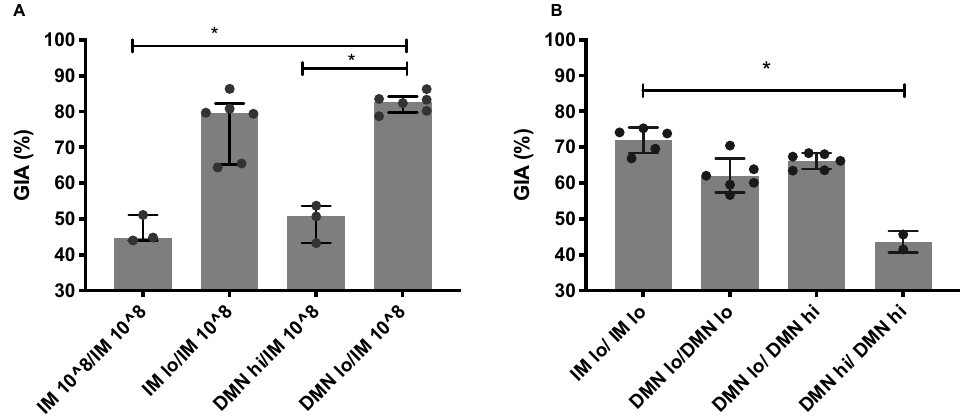
Figure 4. The dose and route of immunization impacts on functional antibody activity against malaria parasites. Female Balb/c mice ( n = 10 per group) were immunized on day 0 with AdHu5–PfRH5 by the IM route or using DMN patches. The conventional priming and boosting by the IM route, used 1 × 10 8 ifu and acted as a control regime. Alternatively, mice were administered a low dose of 5 × 10 4 ifu by IM injection or DMN patch (“IM lo” or “DMN lo”) or a high dose of 5 × 10 7 ifu by DMN patch (“DMN hi”) . All mice were boosted on day 54 with ( A ) the control dose of 1 × 10 8 ifu by the IM route, or ( B ) with a low or high dose of vaccine by the indicated route. The level of growth inhibitory antibodies to P. falciparum 3D7 clone blood-stage parasites was assessed in purified IgG from serum taken 4 weeks post-boost and pooled into 2 to 6 samples, depending on volumes of available serum. * p < 0.05, by one-way ANOVA. Bars represent median, error bars represent interquartile range, circles represent individual samples.